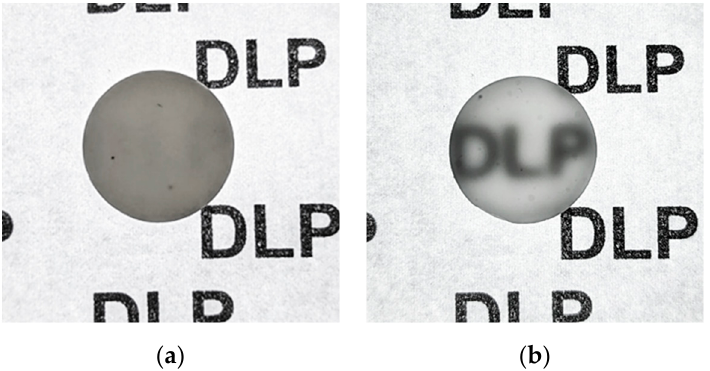
Figure 19. ( a ) Sample prepared following the process recipe herein described; ( b ) sample prepared following the process recipe herein described with the addition of MgO as a sintering aid.